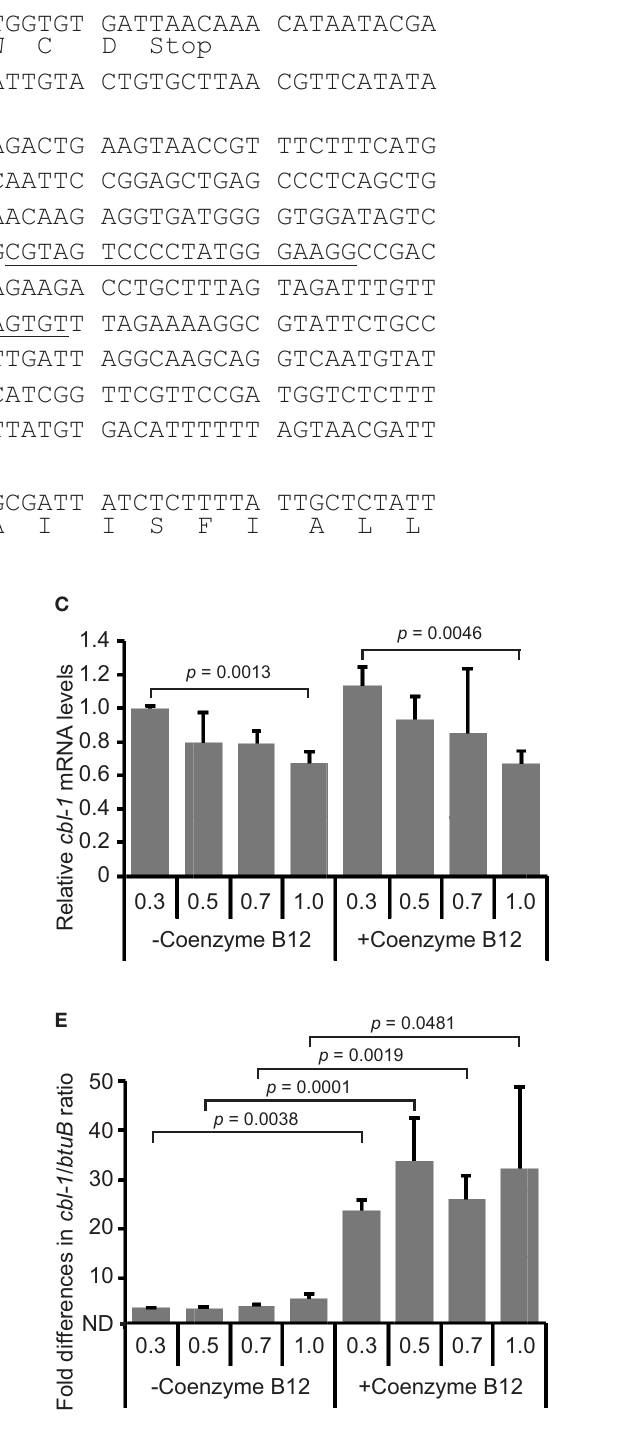
FIGURE 2 |Transcriptional organization and regulation of the cbl-1 - btuB (PGN_0704) region in the P. gingivalis chromosome. (A) Based on 5 (cid:48) -RACE, the transcriptional start site for cbl-1 - btuB mRNA was mapped to a G (in bold italic and labeled + 1) 430bp upstream of the ATG start codon of btuB . Primers in the cbl-1 region used for RT-PCR in (B) and qRT-PCR in (C–E) are underlined. (B) RT-PCR of genomic DNA or cDNA with primers amplifying cbl-1 , btuB or cbl-1 ,